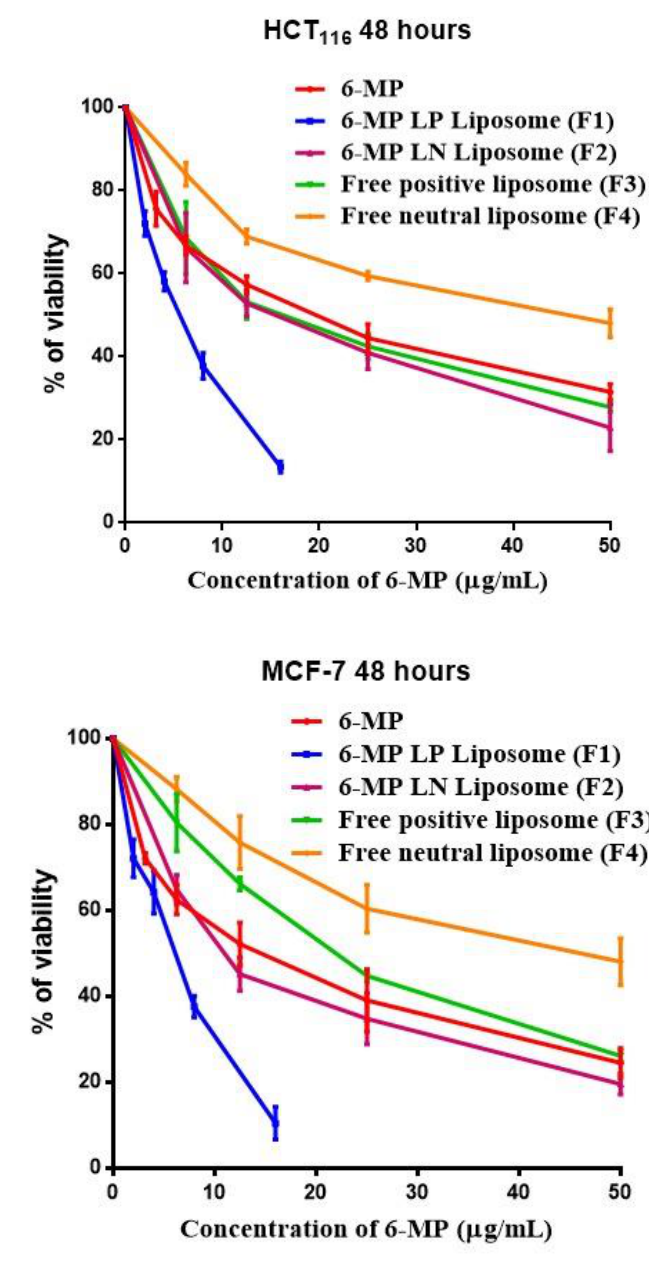
Figure 1. Percentage of cell viability of HepG2 ( A ), HCTT 116 ( B ), and MCF-7 ( C ) after treatment with different concentrations of free 6-MP and the prepared liposomal formulations.